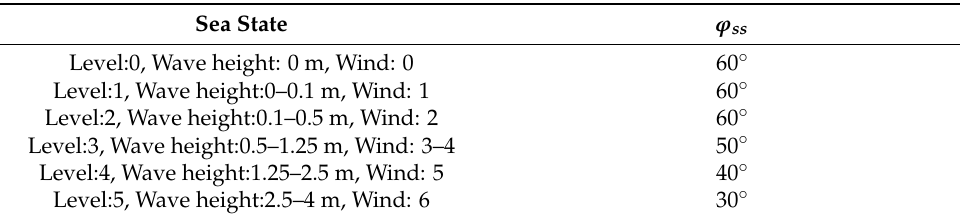
Table 2. Weather constraints under different sea